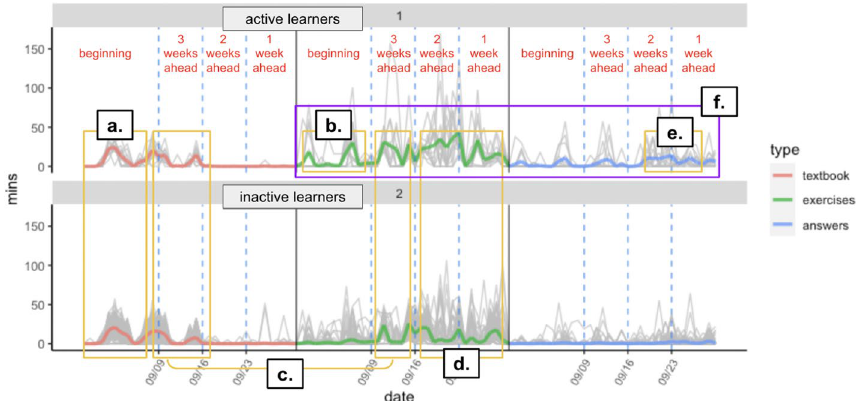
Fig. 6 Clusters of patterns of daily reading time